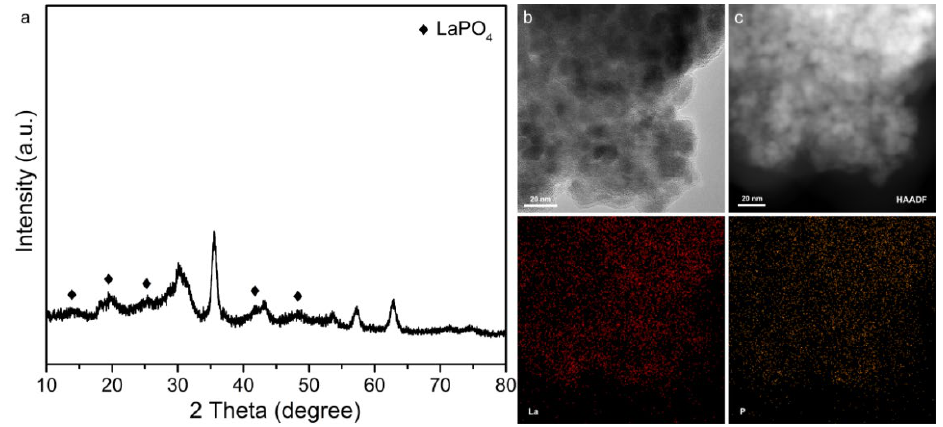
Figure 9. ( a ) XRD pattern of MALS-B after phosphate adsorption; ( b ) TEM image of MALS-B after phosphate adsorption; ( c ) HAADF-STEM image and corresponding La, P elemental mapping distribution of MALS-B after phosphate adsorption.